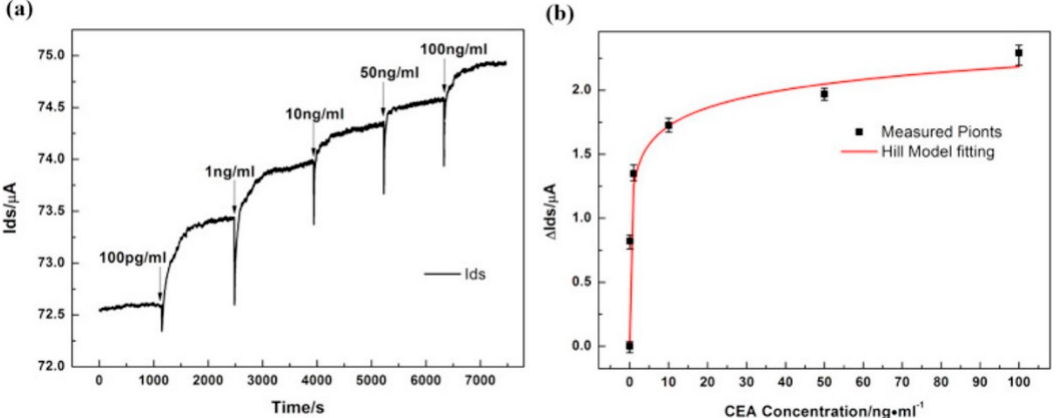
Figure 10. ( a ) Drain-source current response at the time-dependent introduction of various carcinoembryonic antigen (CEA) concentrations; ( b ) Drain-source current against CEA concentration